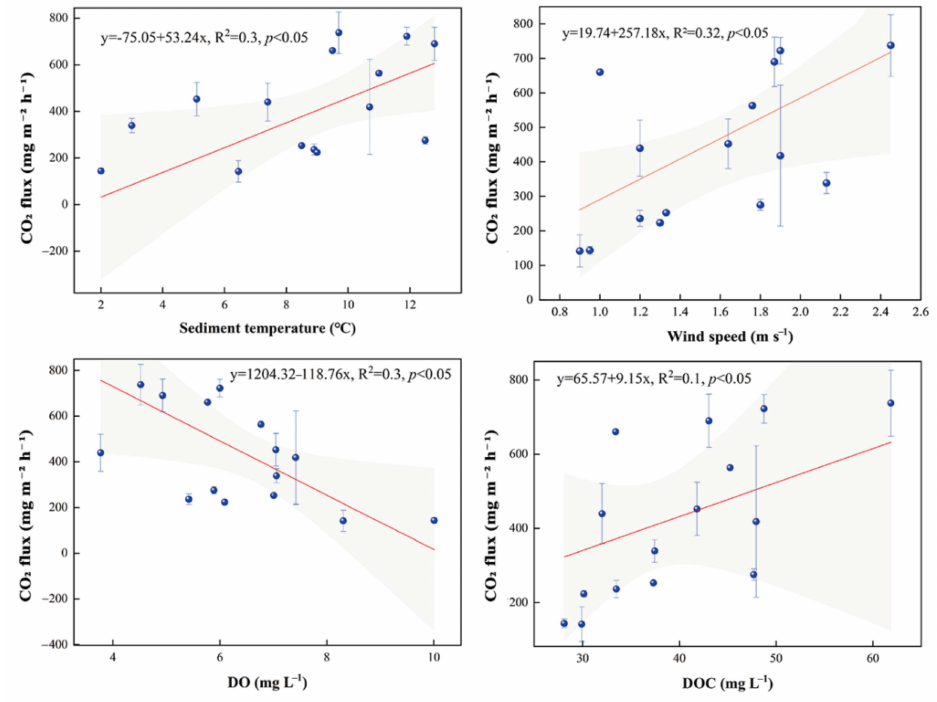
Figure 6. Correlation of CO 2 fluxes in the palafic zone with sediment temperature, wind speed, DO and dissolved organic carbon